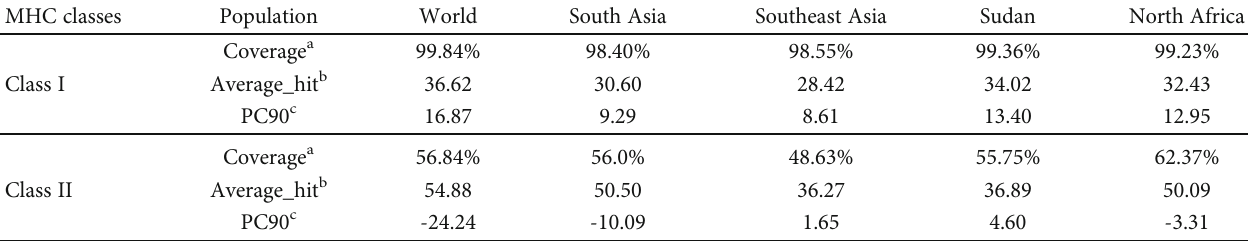
Table 4: A population coverage for all epitopes that bind to MHC classes I and II alleles from di ff erent parts of the world. MHC classes